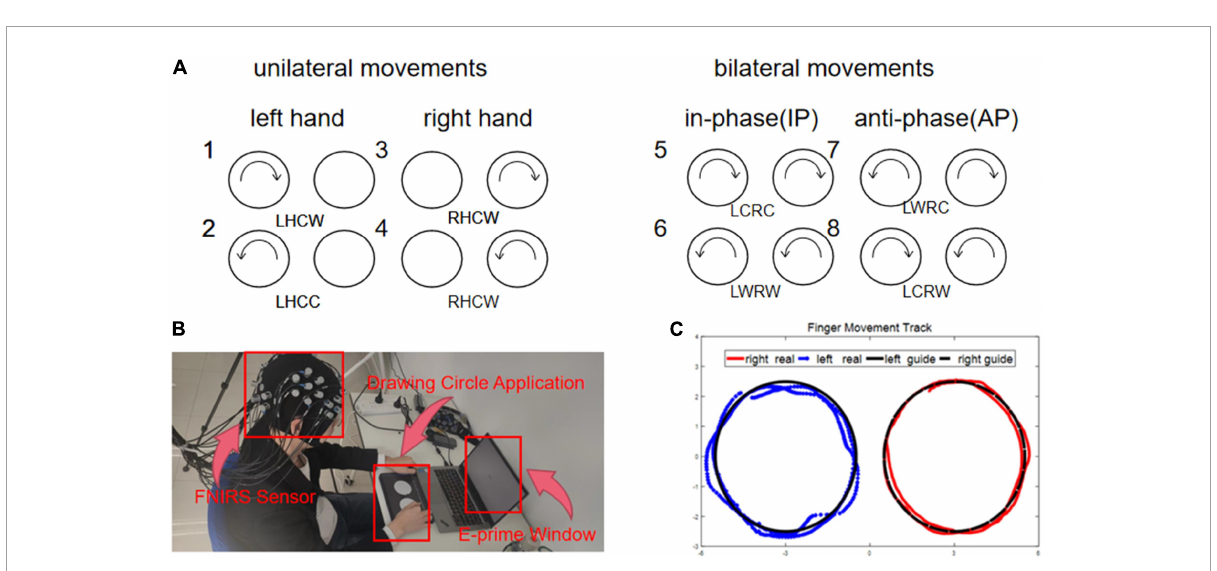
FIGURE2 (A) Condition 1–2: left side tasks, condition 3–4: right side tasks, condition 5–6: anti-phase tasks, condition 7–8: in-phase tasks. (B) Position 1: hat with sensors, position 2: the application interface of collecting finger movement trajectory, position 3: the interface of E-prime. (C) The data of motion track. (1) the blue line was the real trajectory of left hand, (2) the red line was the real trajectory of right hand, and (3) the black line was the guide trajectory.